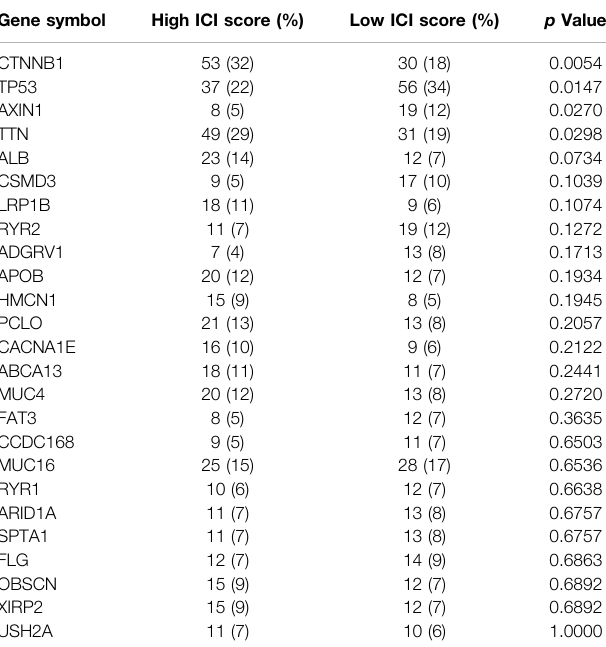
TABLE 1 | The association of ICI scores with somatic cell variation, where chi- square tests were used to compare statistical differences between high and low ICI score